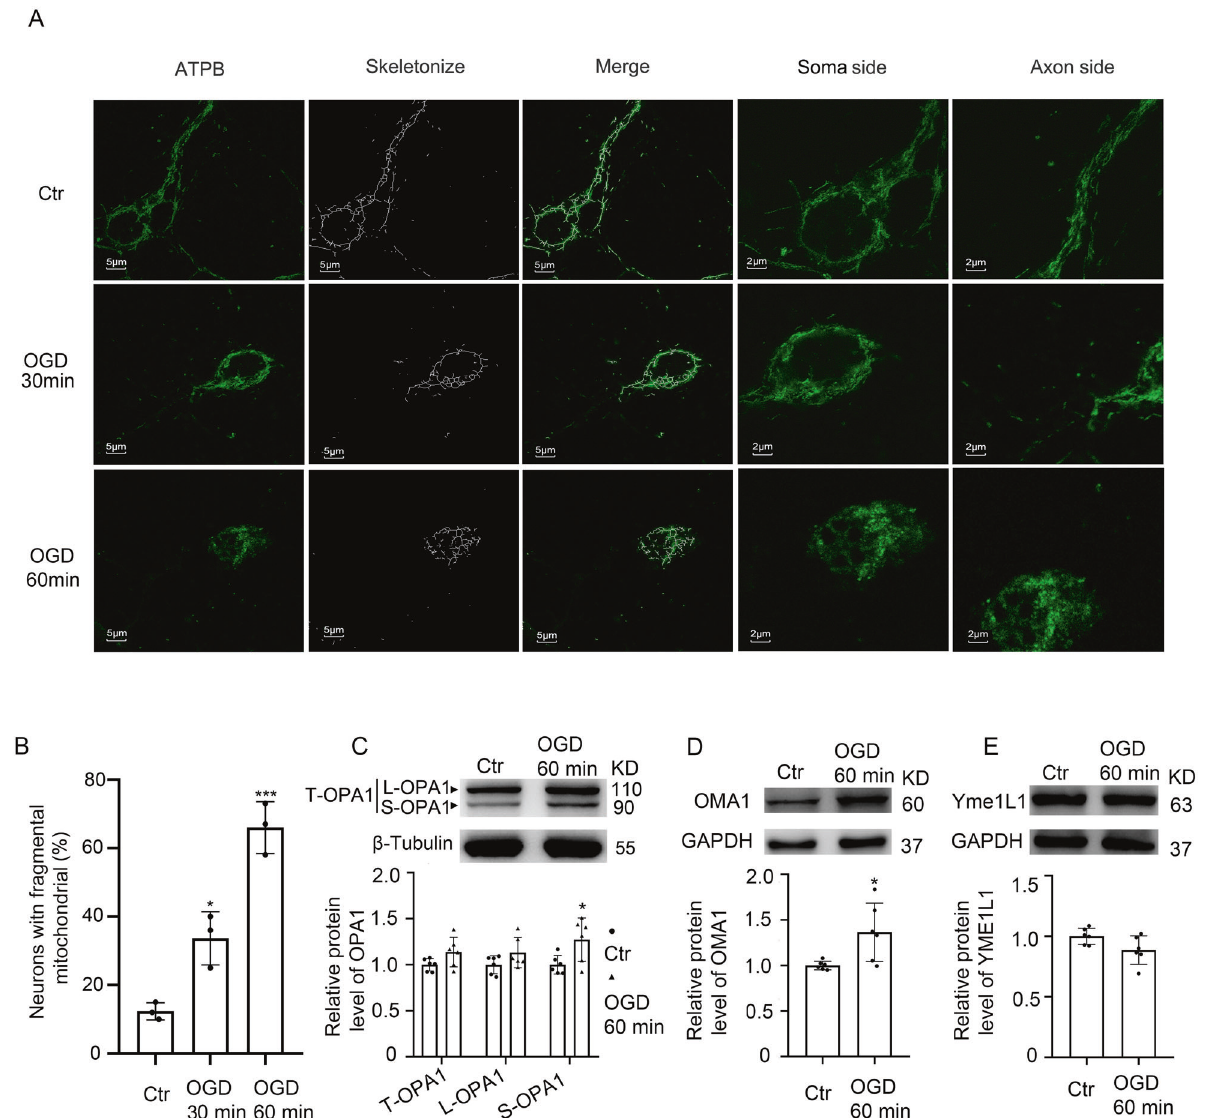
Fig. 1 Changes in neuronal mitochondrial networks and OPA1 protein cleavage after OGD. A Representative confocal images of mitochondrial networks under normal condition and OGD injury at different times. B Representative quantitative results of the percentage of neurons with fragmented mitochondria. Approximately 70 – 80 cells per experiment were scored. Neuron with fragmented mitochondria: the majority of mitochondria in the neuron displayed a short, fragmented shape, with a length shorter than 20 pixels. *** p < 0.001 vs. control group, * p < 0.05 vs. control group; Scale bar = 5 μ m; n = 3. C Western blot analysis and quanti fi cation of long and short OPA1 levels in cultured neurons. D , E Western blot analysis and quanti fi cation of OMA1 and YME1L1 levels in cultured neurons. * p < 0.05 vs. control group; n =